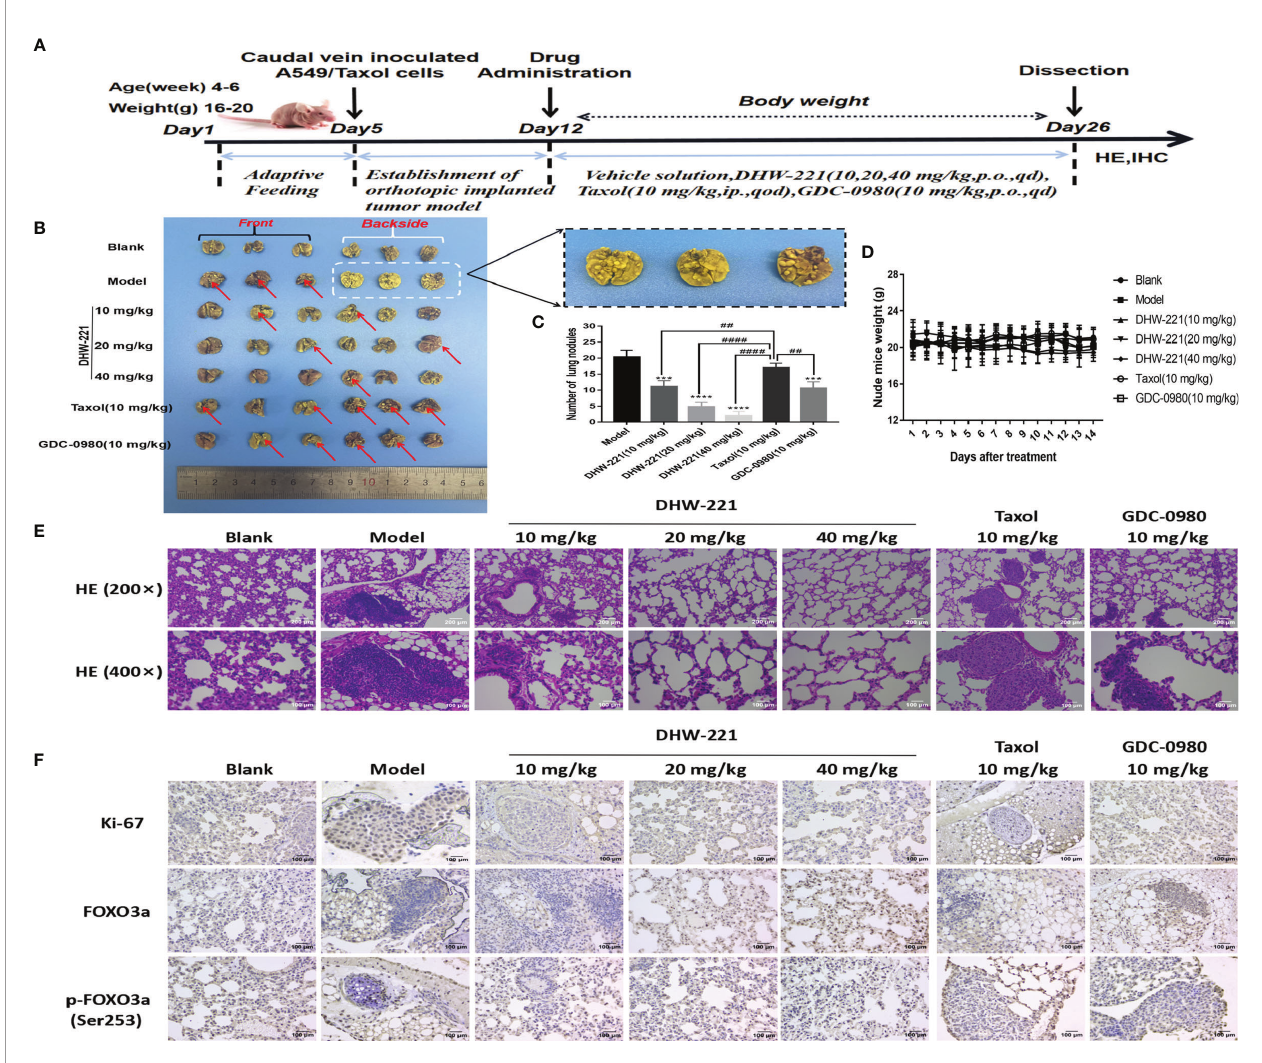
FIGURE 7 | DHW-221 inhibits tumor growth in an orthotopic A549/Taxol nude mice model by tail vein. (A) The schematic fi gure of tumor modeling nude mice and drug administration. (B) Front and back images of orthotopic A549/Taxol lung samples in nude mice based on the Bouin ’ s staining (n = 6). Arrows and enlarged parts indicated nodules formed in the lungs. (C) Statistical analysis of the number of lung nodules in mice in each group (n=6). Statistical comparisons were performed with one-way ANOVA followed by Dunnett ’ s post-hoc test for multiple comparisons. Data were presented as mean ± SD. ***p < 0.001, ****p < 0.0001 versus control. ## p < 0.01, #### p < 0.0001 versus taxol. (D) Body weight change curve of nude mice after DHW-221, GDC-0980, and Taxol administrations. (E) Hematoxylin and eosin (HE) staining of lung tissues in each group under different magni fi cations (200× and 400×). Scale bar = 200 and 100 µm. (F) The expressions of Ki67, FOXO3a, and p-FOXO3a in lung tissues were detected by immunohistochemistry. Scale bar = 100